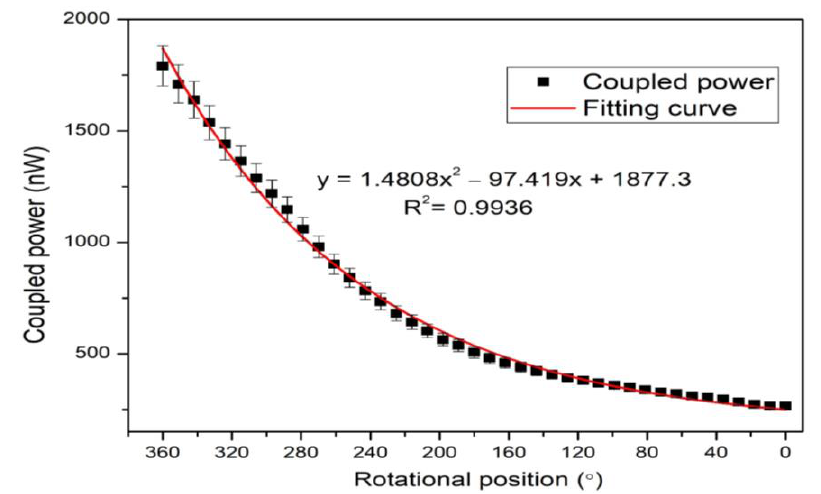
Figure 5. The clockwise measurement of the rotational sensor.